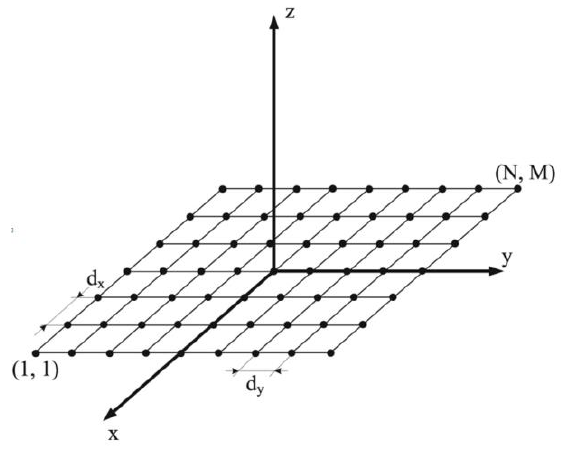
Fig. 1. Scheme of placement of generators in the